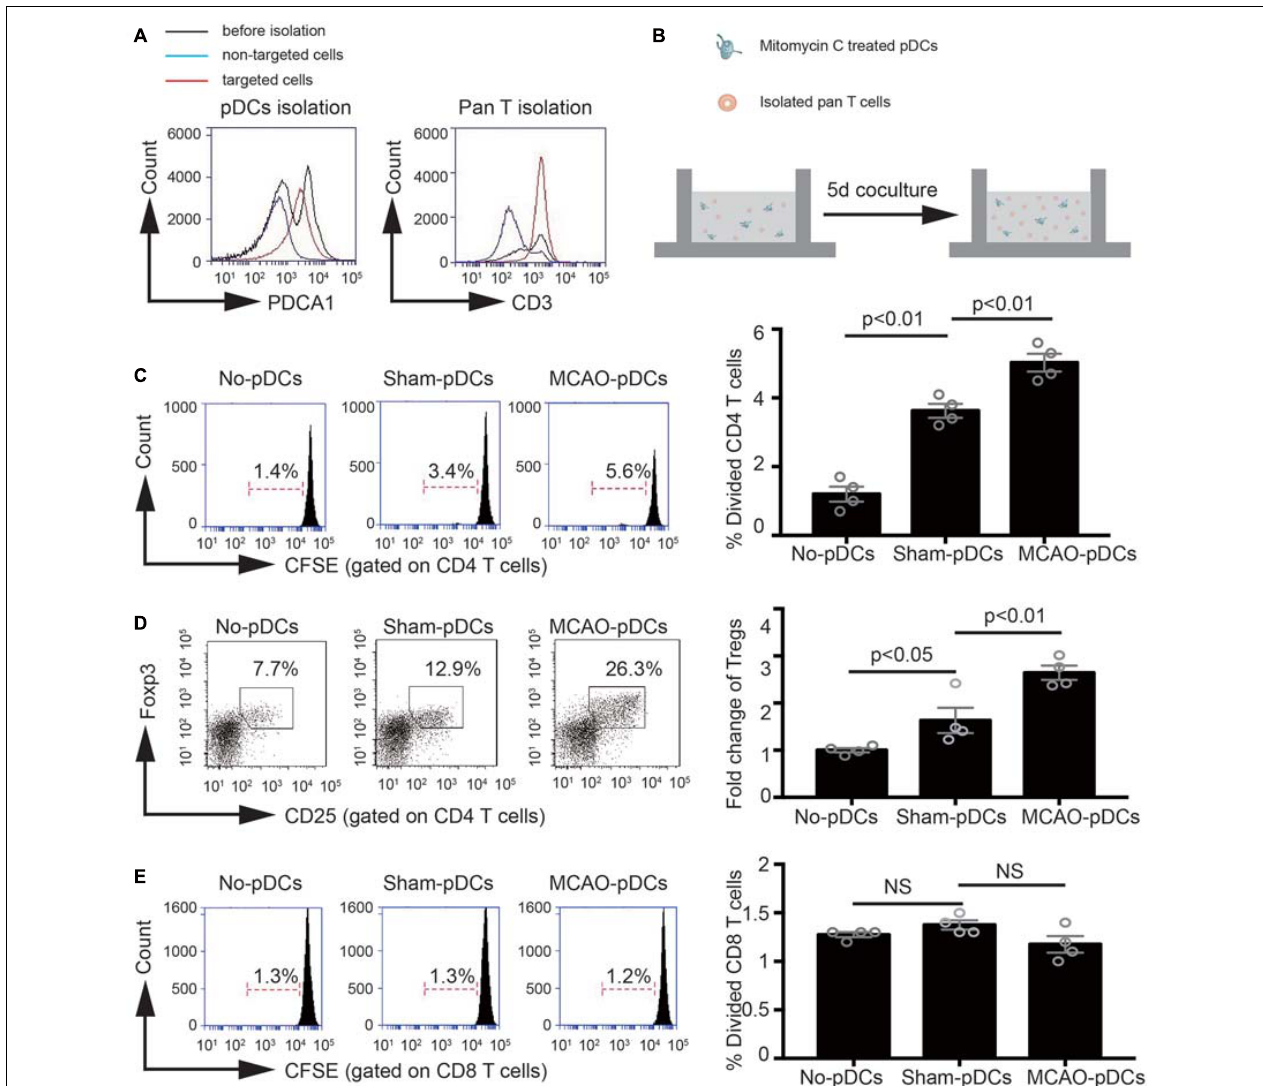
FIGURE 5 | The pDCs accelerates the Tregs induction under the pathologic state of stroke. Brain ischemia was induced by 45 min MCAO. Sham-operated animals underwent surgical exposure of the right middle cerebral artery without occlusion. The splenic pDCs and allogeneic T lymphocytes were purified through magnetic isolation and cocultured by 1:10 for 5 days in vitro . The phenotype and proliferation of T lymphocytes were analyzed with flow cytometry. (A) The pDCs and pan T cells were isolated from a mouse spleen cell suspension by using the magnetic isolation kit. (B) Schematic illustration of mixed lymphocytes reaction. (C) In vitro proliferation of CD4 T lymphocytes, assays were performed with the fluorescent dye CFSE and analyzed by flow cytometry. (D) At day 5 of coculture, cells were harvested and the Tregs (CD25+ Foxp3+ population gated on the CD4 T cells) were analyzed by flow cytometry. Indicated numbers are the mean percentages of gated cells. (E) In vitro proliferation of CD8 T lymphocytes, assays were performed with the fluorescent dye CFSE and analyzed by flow cytometry. The loss of CFSE fluorescence reflects cellular division. Indicated numbers are the percentages of dividing cells. Data are expressed as means ± SEM for n = 4 mice per group. The scatter plots represent independent samples. NS: no